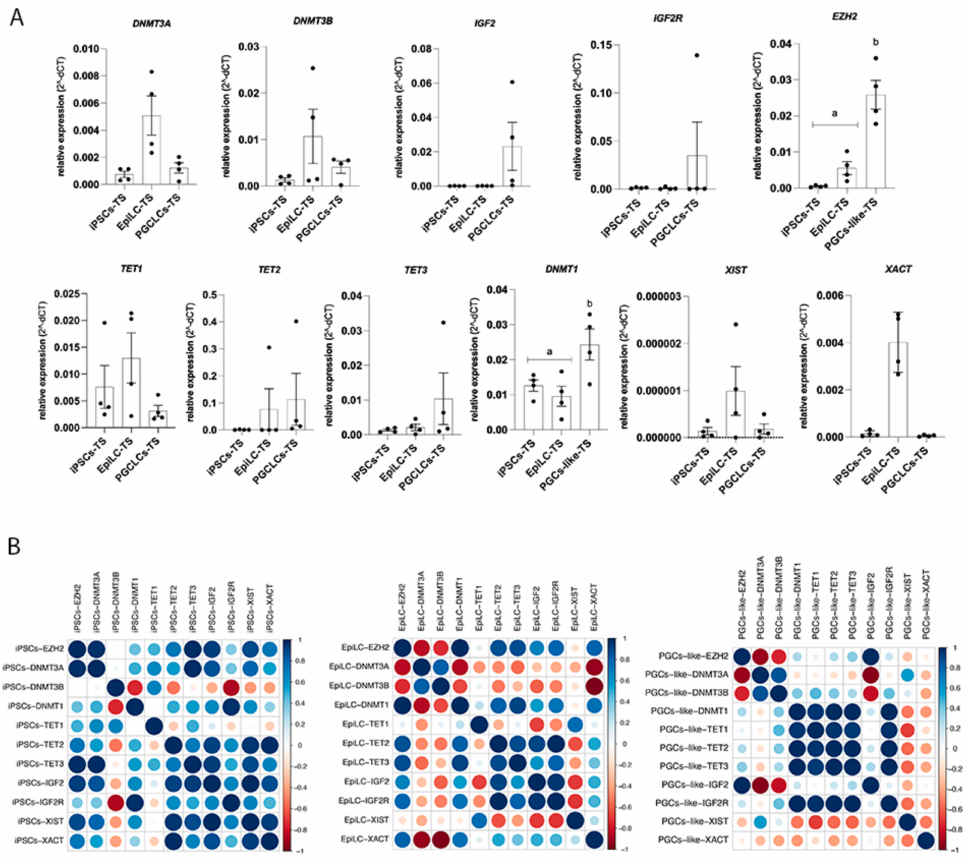
Figure 7. Epigenetic profile during PGCLCS-TS induction. ( A ) hiPSCs-TS (p20), hEpiLC-TS (D.2), and hPGCLCs-TS (D.6) quantification of the relative expression of genes associated with epigenetic marks. Individual reactions of qRT-PCR were normalized to the B-ACTIN gene. The data was compiled from at least four biological replicates and three technical replicates. p values were calculated by Two-way ANOVA, followed by Tukey’s multiple comparisons test as appropriate. (letters a-b show difference between groups). EZH2 gene ( p < 0.0001); DNMT1 gene ( p < 0.005). Error bars represent SEM. ( B ) Gene expression correlations were determined according to the Pearson coefficient. The correlation ( Pearson ) profiles of the epigenetics genes during the hiPSCs-TS, hEpiLC-TS, and hPGCs-TS periods. Dark blue indicates a positive correlation, and dark red indicates a negative